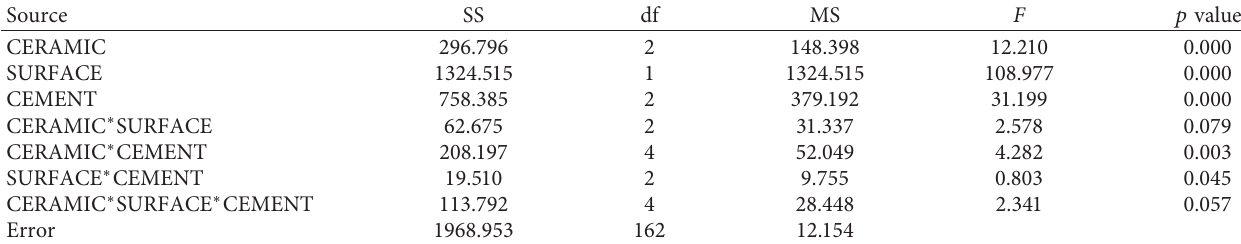
Table 3: The statistic results of an analysis of variance (ANOVA) of shear bond strength upon each variable tested. Source SS